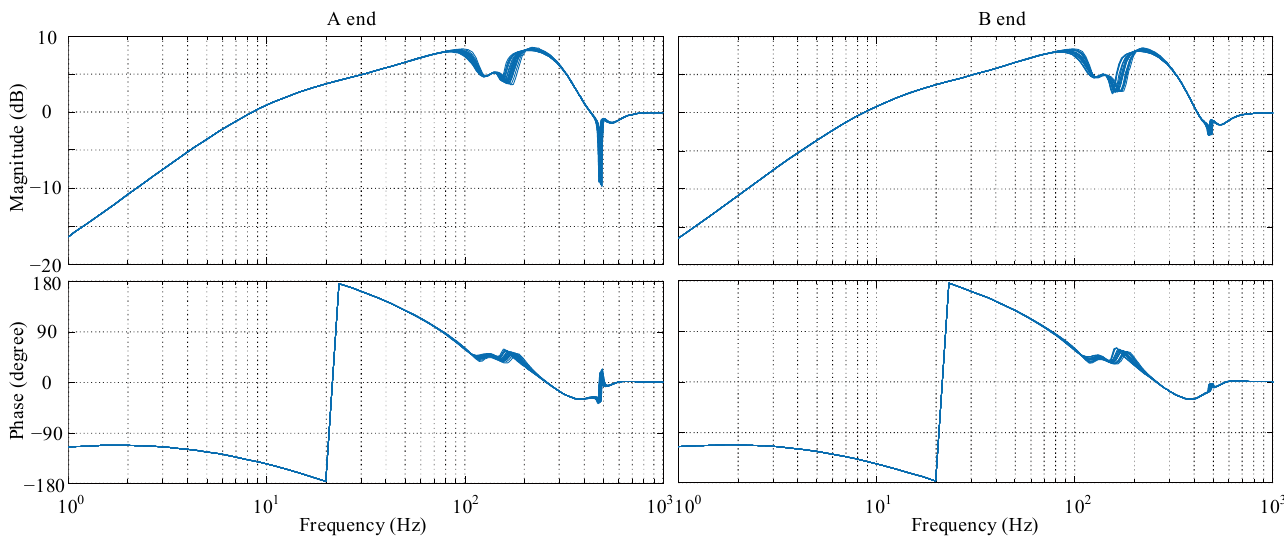
Figure 12. S ensitivity function of the closed-loop system.